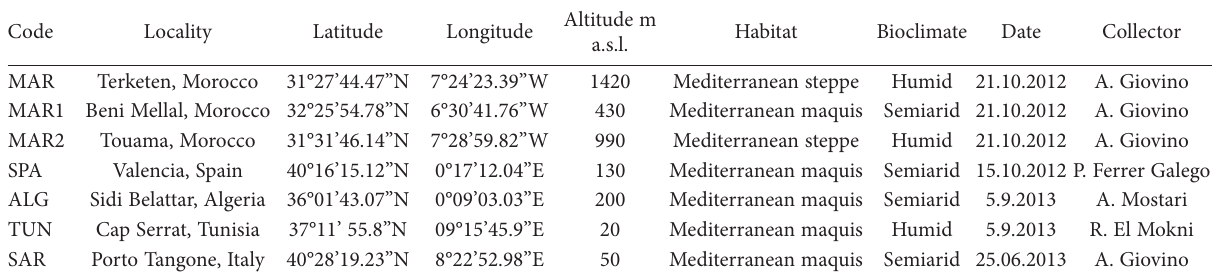
Table 1. Sampled populations, environmental characteristics and seeds collection data.